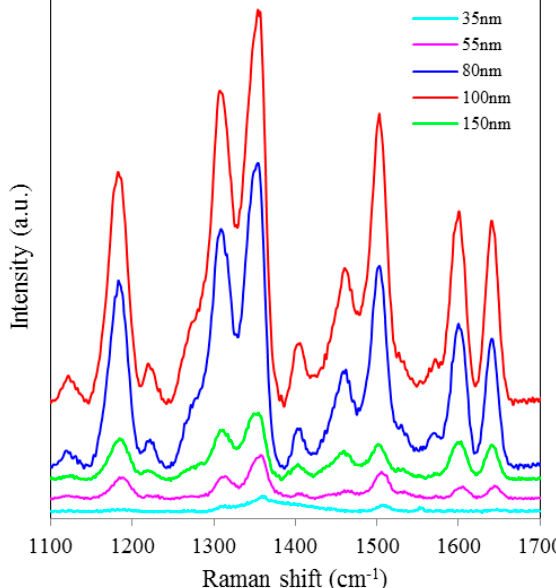
Figure 8. SERS spectra of 8 × 10 − 5 M solution of Rh6G dye adsorbed on the surface of 120 nm thick gold film deposited on 35, 55, 80, 100, and 150 nm nanoporous substrates measured at 3 s integration time.